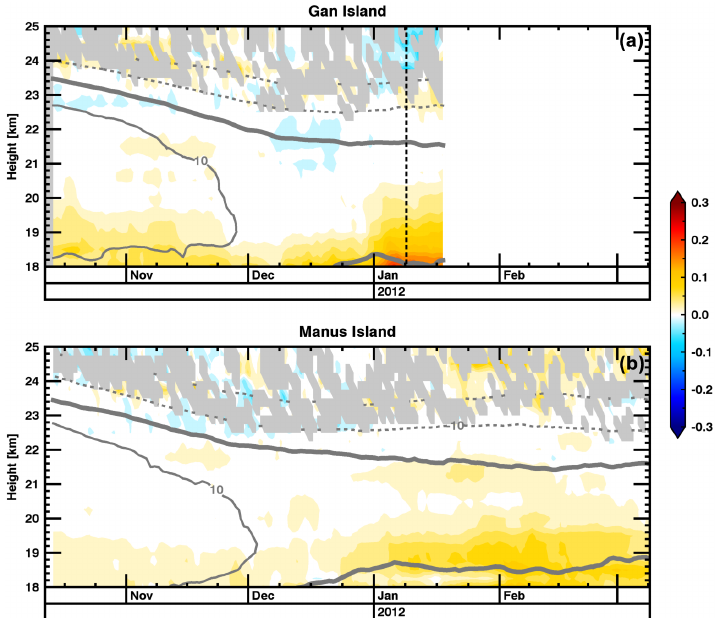
Figure 3. Time series of 5–20-day Kelvin wave momentum fluxes (shading) for Gan Island (a) and Manus Island (b) over the DYNAMO field campaign. The dark gray contours give the estimated zonal mean zonal wind at each site; solid contours are westerlies, while dashed contours are easterlies. The 0ms − 1 contour is shown in bold gray. The vertical black dashed line denotes the central date of the window used in Fig. 1. Light gray shading indicates where the momentum flux is not being calculated for any frequency band. Momentum flux is in units of mPa and zonal wind contour spacing is 10ms − 1